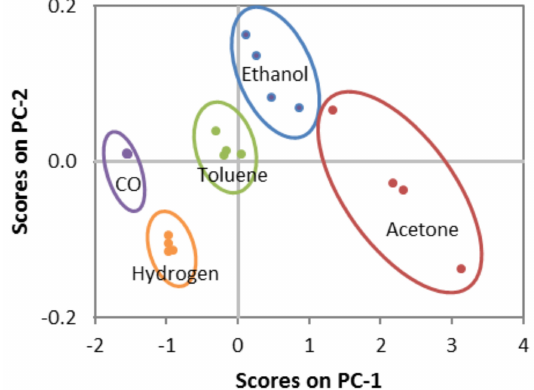
Figure 8. Principal component analysis applied to discriminate the tested VOCs by using an array of non-modified tungsten oxide wires and the cerium oxide-tungsten oxide core-shell wire-based